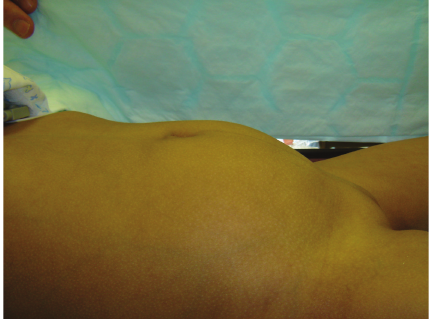
Figure 1: Prominent mass lower abdomen.